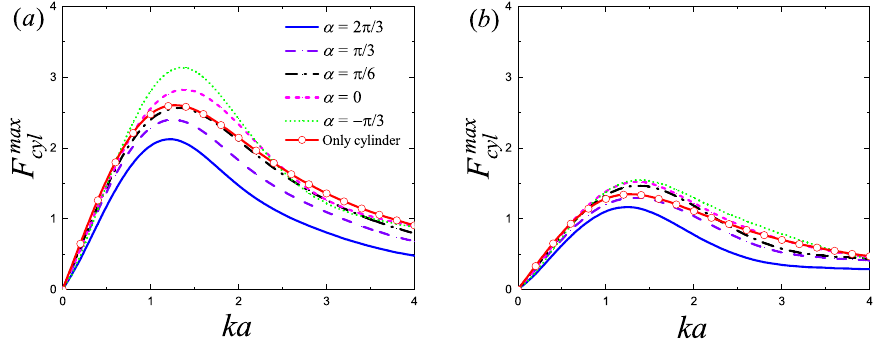
Figure 13. Variation in non-dimensional wave force on the interior cylinder for different α with a / b = 2, a / h = 1, β = π /3, G = 1, U 0 = 0.4 m/s, α = 2 π /3, and γ = 2 π /3: ( a ) k x / k = 1; ( b ) k x / k =